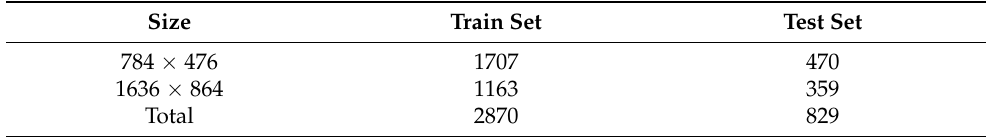
Table 1. Details of data division in DR image of injection